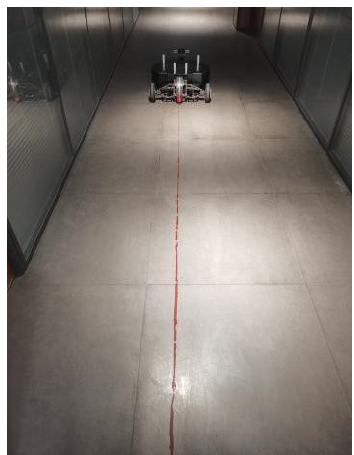
Figure 18. Experiment scene of straight-line motion in the laboratory.